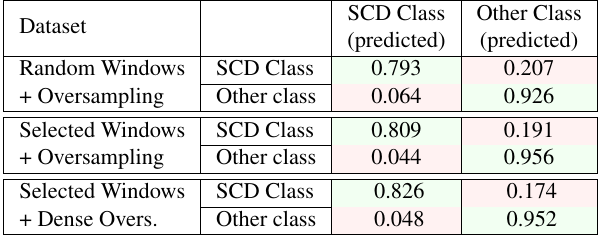
Table 3. Comparison between selected and random areas.